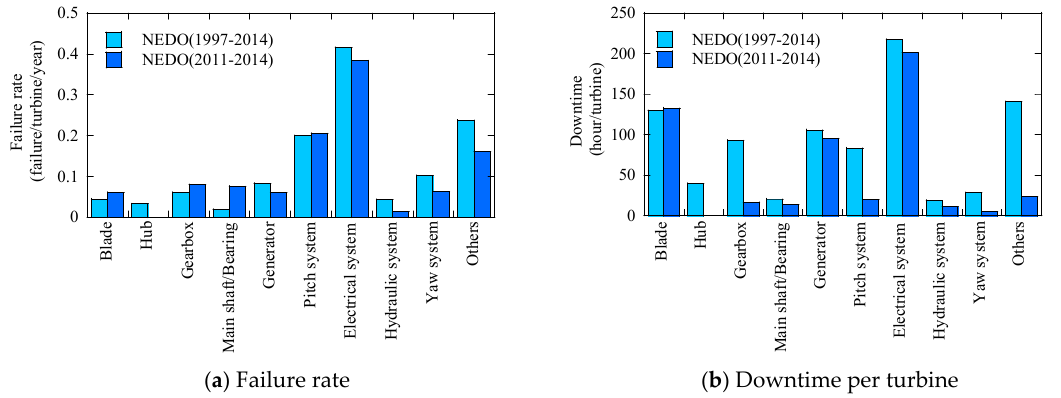
( b ) Downtime per turbine Figure 2. Comparison of ( a ) failure rate and ( b ) downtime between 1997–2014 and 2011–2014 NEDO databases.